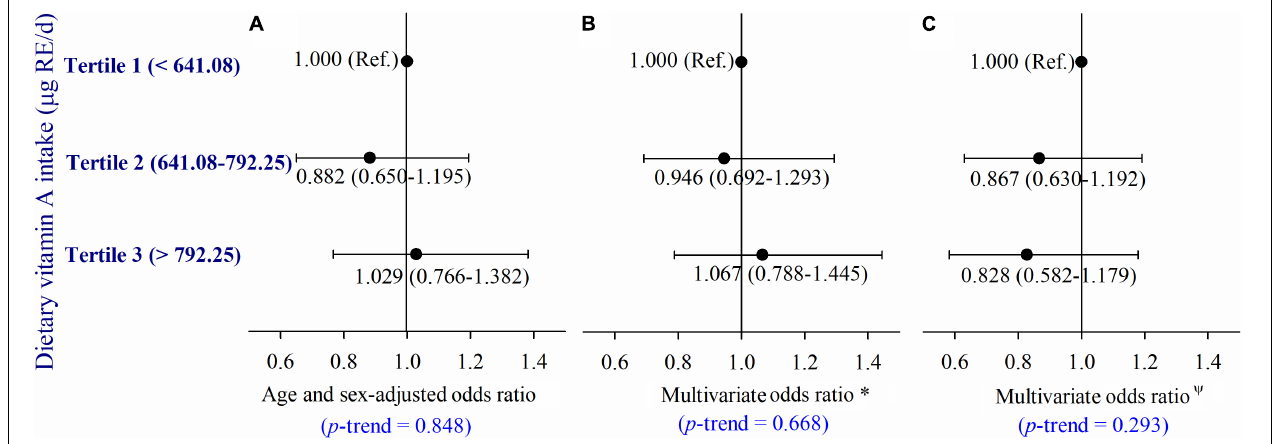
FIGURE 6 | (A–C) Adjusted ORs (and 95% CIs) of type 2 diabetes by dietary vitamin A intake at baseline. *Multivariate ORs were adjusted for age, sex, current smoker, current drinker, exercised regularly, education level, physical activity, BMI, hypertension, hyperlipidemia, coronary disease, and a family history of diabetes; (cid:57) Multivariate ORs were adjusted for age, gender, current smoker, current drinker, exercising regularly, education level, physical activity, BMI, hypertension, hyperlipidemia, coronary disease and a family history of diabetes, dietary energy intake, and dietary lipid intake.